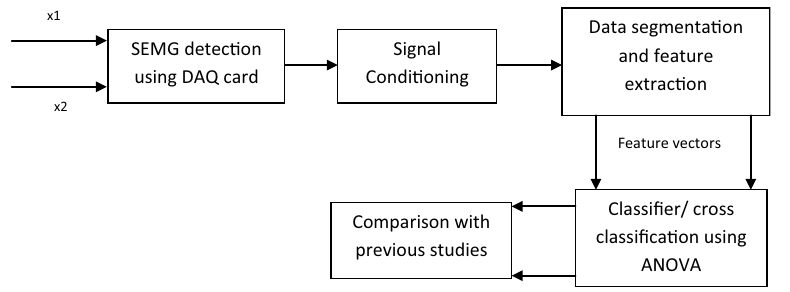
Fig. 1. Schematic of upper arm